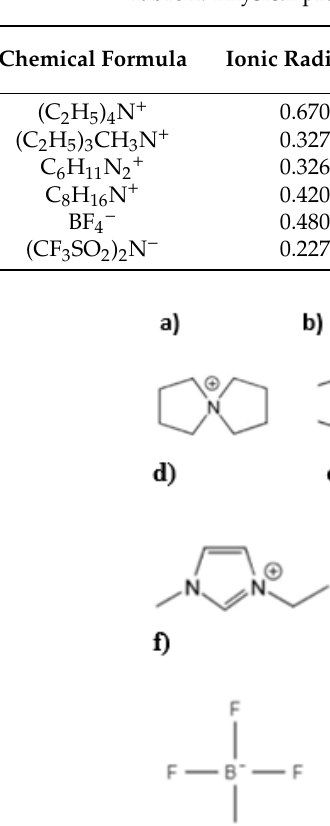
Table 2. Physical properties of electrolytes and ions.